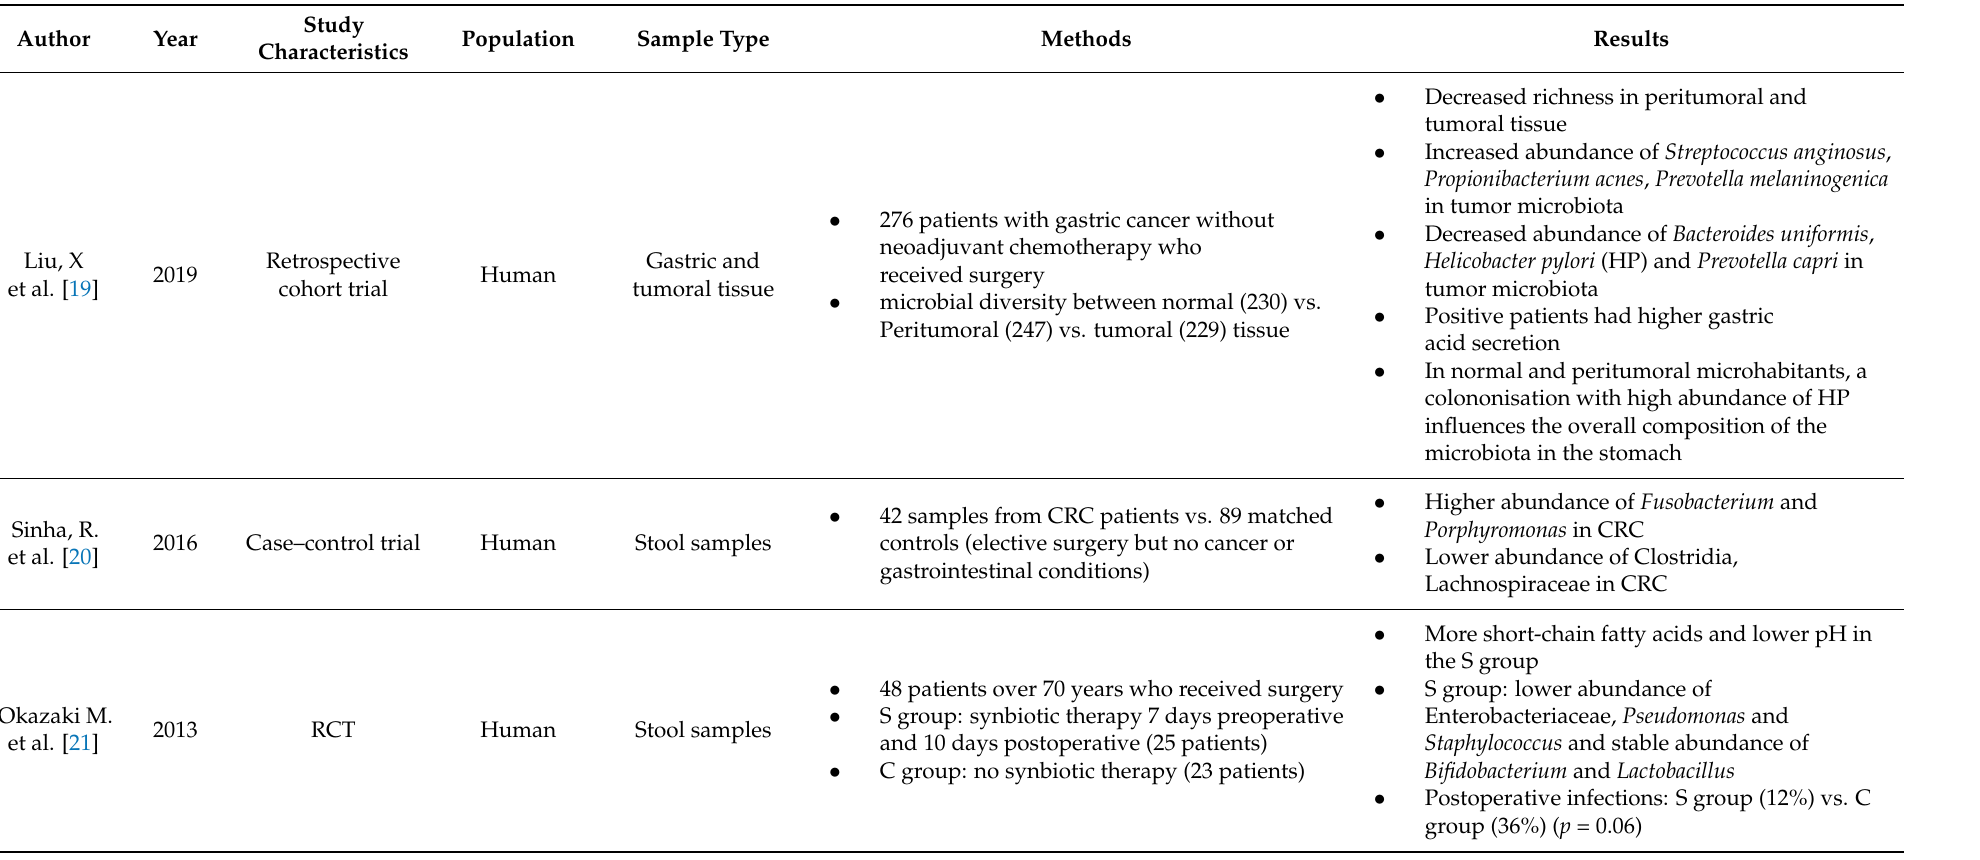
Table 1. Study characteristics of included original papers. AL—anastomotic leakage, CID—chemotherapy-induced diarrhoea, CRC—colorectal carcinoma, GC—gastric cancer, RE— radiation enteropathy, RCT—randomized control trial, SSI—surgical site